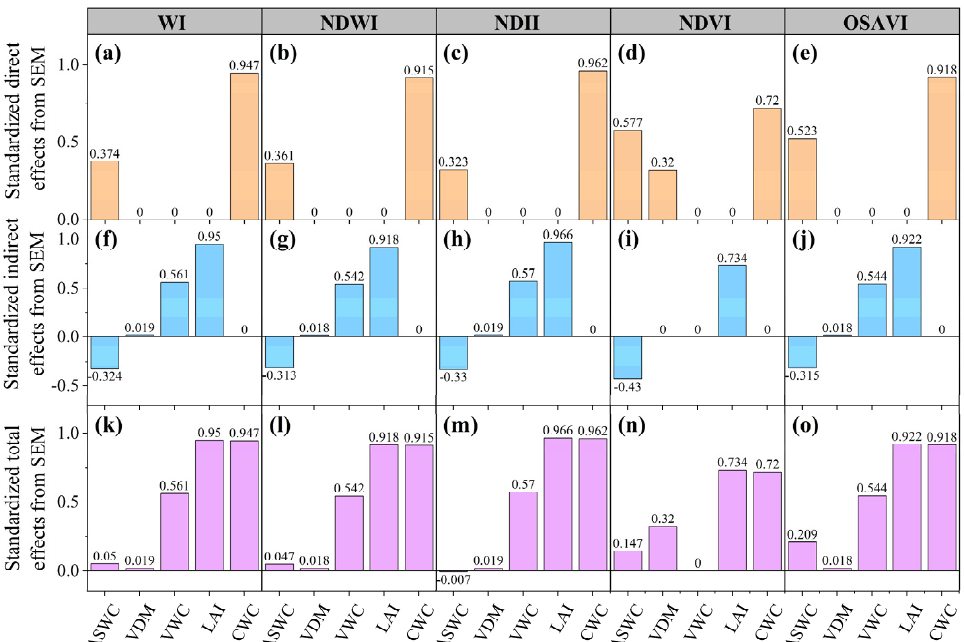
Figure 8. Standardized direct ( a – e ), indirect ( f – j ), and total effects ( k – o ) on the spectral vegetation indices derived from the structural equation model (SEM). ASWC, available soil water content; LAI, leaf area index; CWC, canopy water content; VDM, vegetation dry mass; VWC, vegetation water content; WI, water index; NDWI, normalized difference water index; NDII, normalized difference infrared index; NDVI, normalized difference vegetation index; and OSAVI, optimal soil-adjusted vegetation